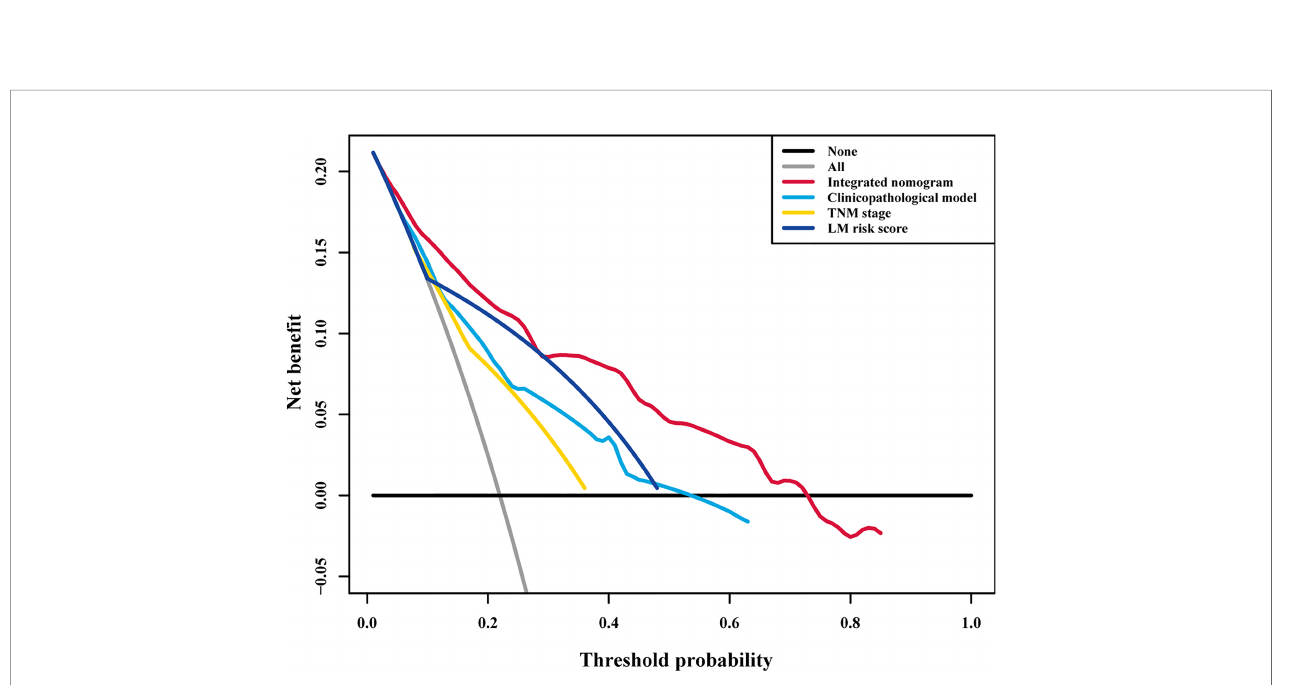
FIGURE 10 | Decision curve analysis for each model in all patients. Decision curve analysis for predicting liver metastasis in all patients. The y-axis measures the net bene fi t, the red line represents the integrated nomogram, the blue line represents the clinicopathological model, the green line represents the LM risk score alone, the yellow line represents TNM stage, the black line represents the assumption that no patients developed liver metastasis, and the gray line represents the assumption that all patients developed liver metastasis. The net bene fi t was calculated by summing the bene fi ts (true positive results) and subtracting the harms (false positive results), weighting the latter by a factor related to the relative harm of an undetected liver metastasis compared with the harm of unnecessary treatment. TNM, tumor-node-metastasis; LM, liver